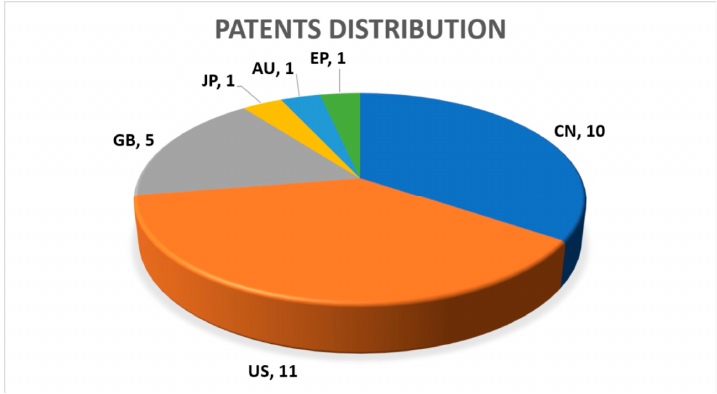
Figure 3. Patent distribution by country: GB (Great Britain), CN (China), US (United States), JP (Japan), EP (European), and AU (Australia). Table 4. List of patents that met the inclusion criteria. Data extracted from patents’ records [47–75]. 191